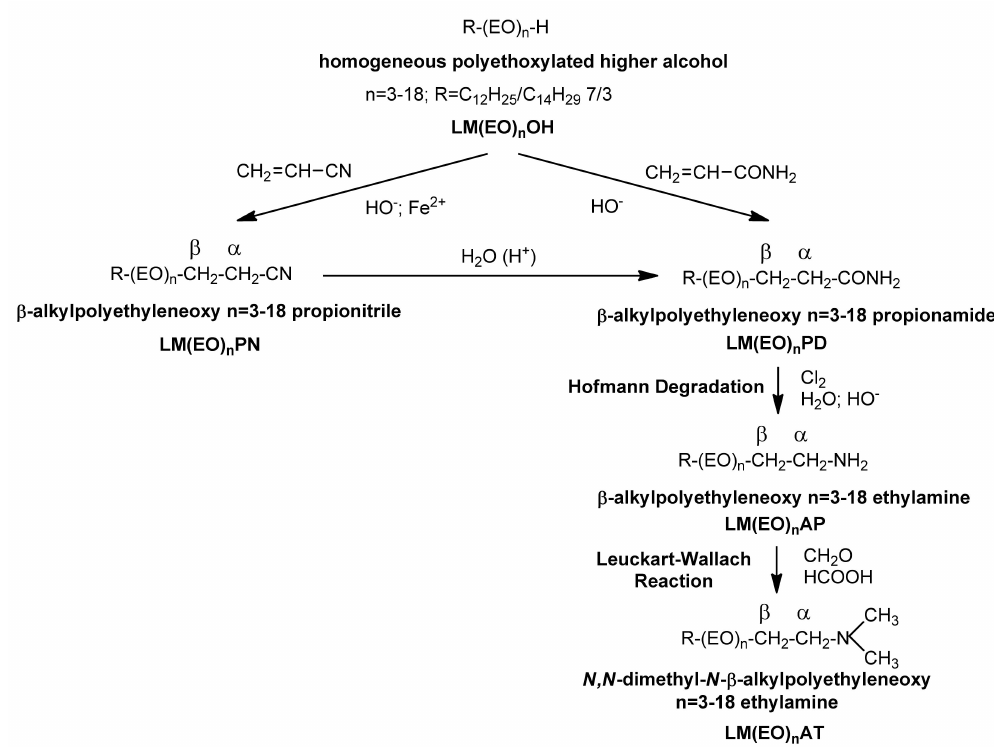
Figure 2. Reaction scheme for obtaining homogeneous tertiary N , N -dimethyl- N - β - lauryl/myristyl 7/3 polyethyleneoxy n = 3–18 ethylamines, LM(EO) n AT, by reductive